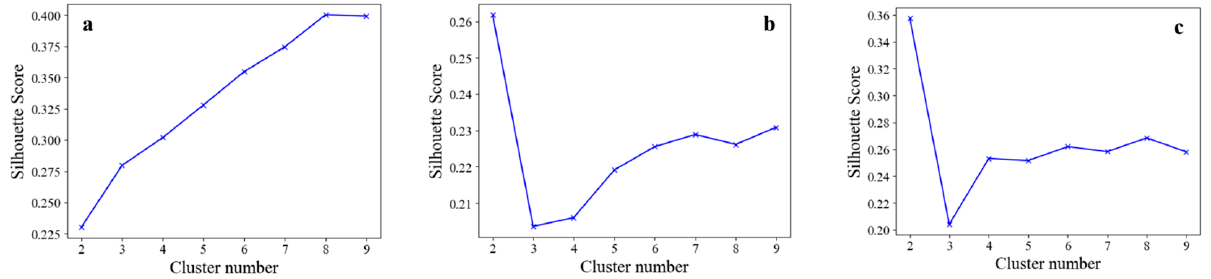
Figure 5. Results of the optimal cluster number selection in Shandong’s living rooms (( a ). Early heating period; ( b ). mid heating period; ( c ). late heating period).